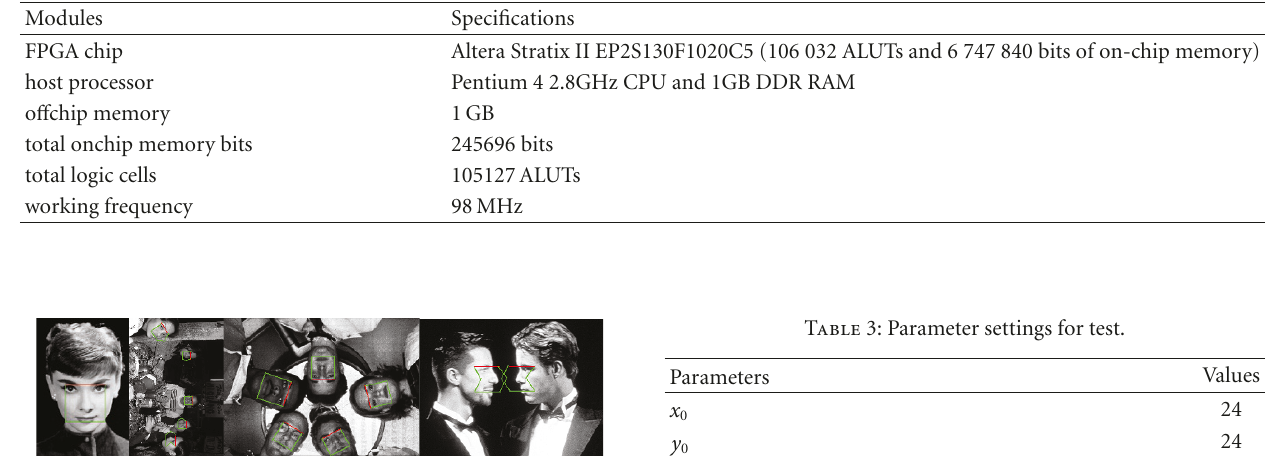
Table 2: Specifications of the proposed hardware prototype